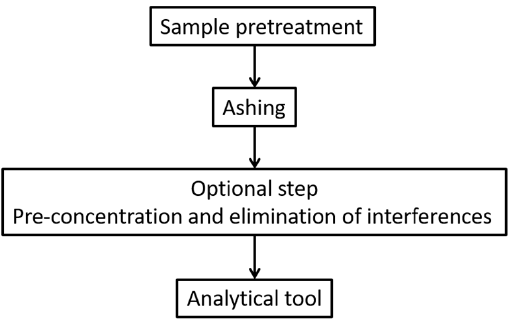
Figure 2. The overall analytical strategy in trace element